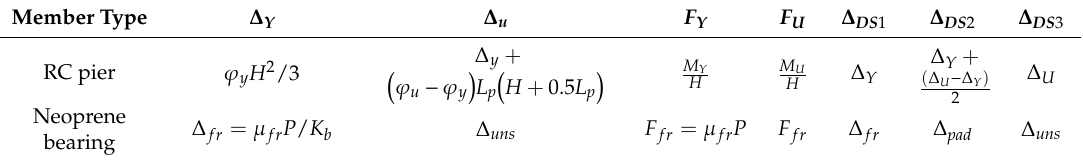
Table 4. Bilinear force-displacement law and damage states for RC piers and neoprene bearings. Member Type ∆ Y ∆ u F Y F U ∆ DS 1 RC pier